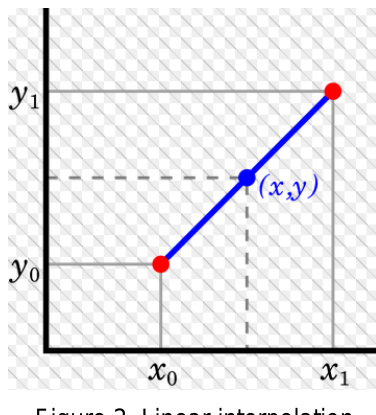
Figure 2. Linear interpolation